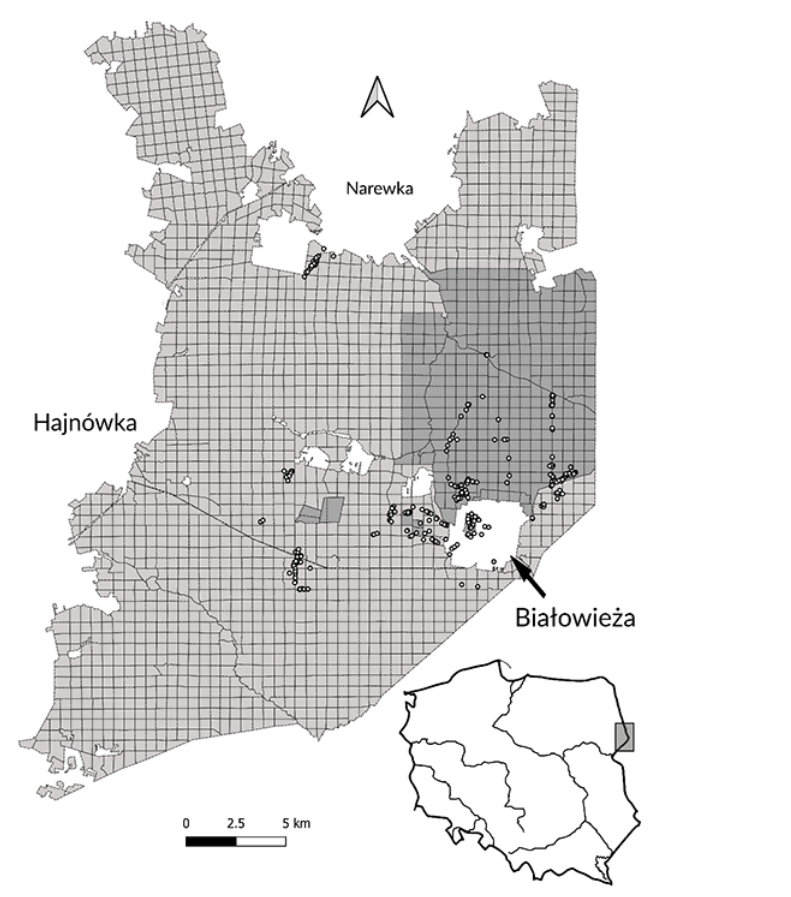
Figure 1 Contour map of the Polish part of Białowieża Primeval Forest showing forest subsections. Białowieża National Park is shown in dark gray. Dots represent records of fungi. Names indicate nearby